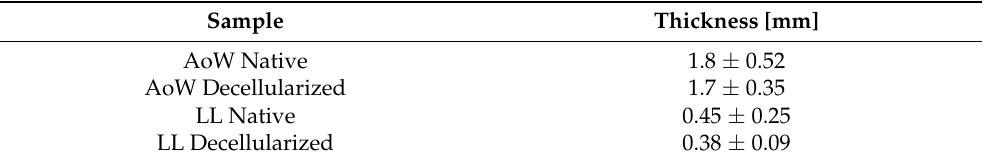
Table 1. Sample thickness measure in Native and Decellularized. Aortic Wall (AoW) and Native Leaflet